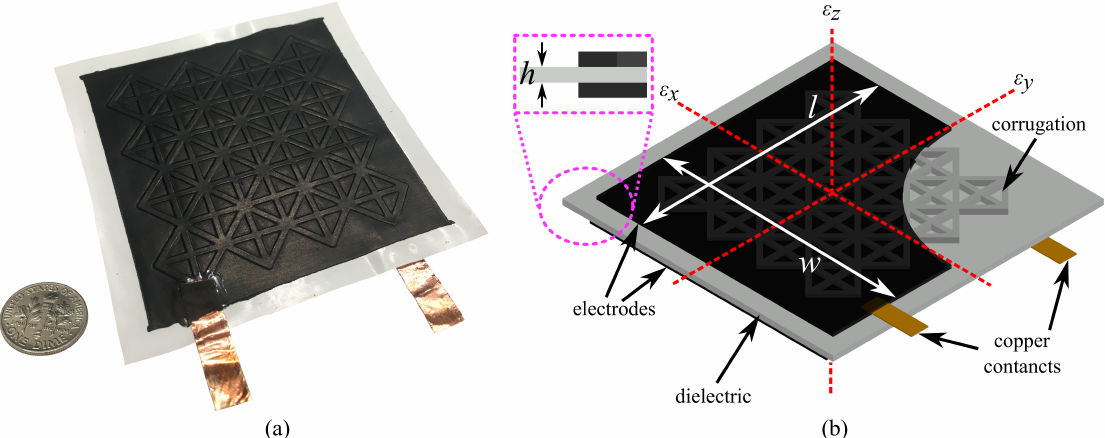
Figure 1. ( a ) Picture of a 76 mm × 76 mm cSEC with a reinforced pattern; ( b ) schematic of a cSEC of thickness h and a section of the electrode layer with electrode area l × w (black